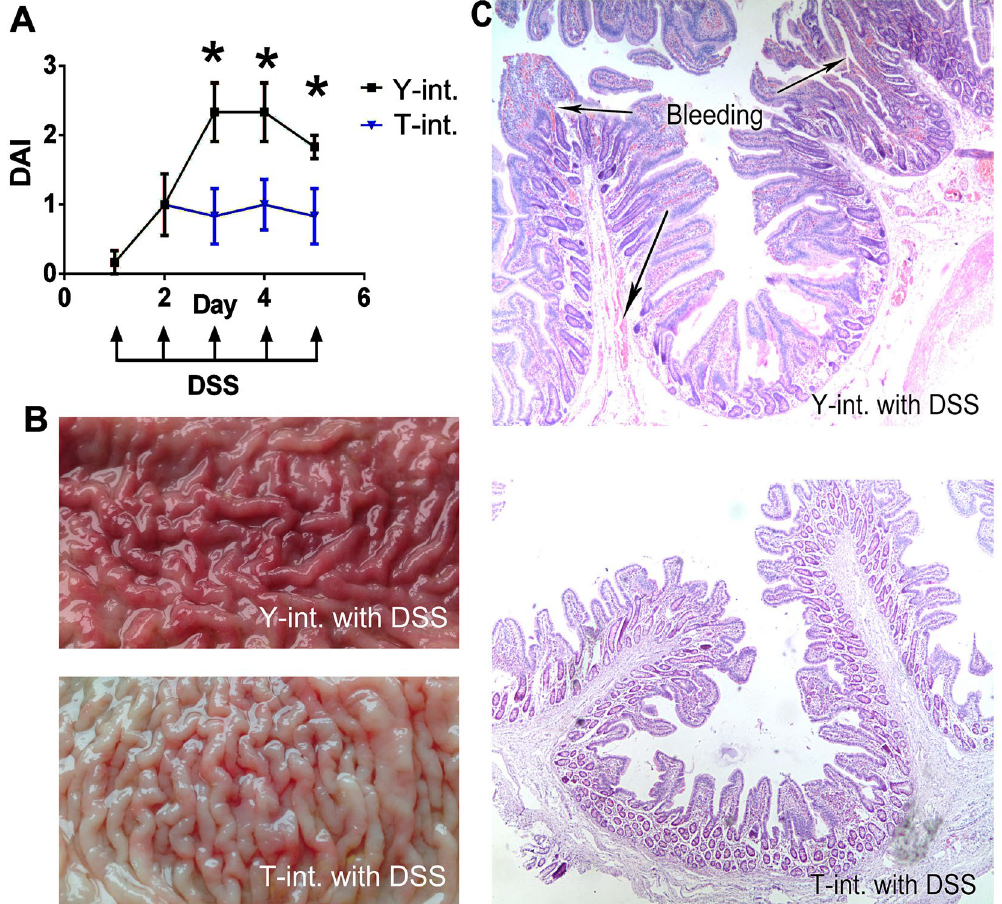
Figure 4. Treatment with the faecal microbiota from Tibetan pigs suppresses experimental colitis in the porcine models. The faecal microbiota of the Yorkshire and Tibetan pigs was transplanted in healthy commercial hybrid newborn piglets to establish the “Yorkshire-intervened” (Y-int.) and “Tibetan-intervened” (T-int.) porcine models. ( A ) Effect of the gut microbiota intervention on the disease activity index (DAI) in Y-int. and T-int. pigs treated with DSS (each n = 6). ( B ) Gross morphology of the colonic mucosal surface after 5 days of DSS administration. ( C ) Haematoxylin and eosin staining of the colon after 5 days of DSS administration (original magnification, x40). * P <